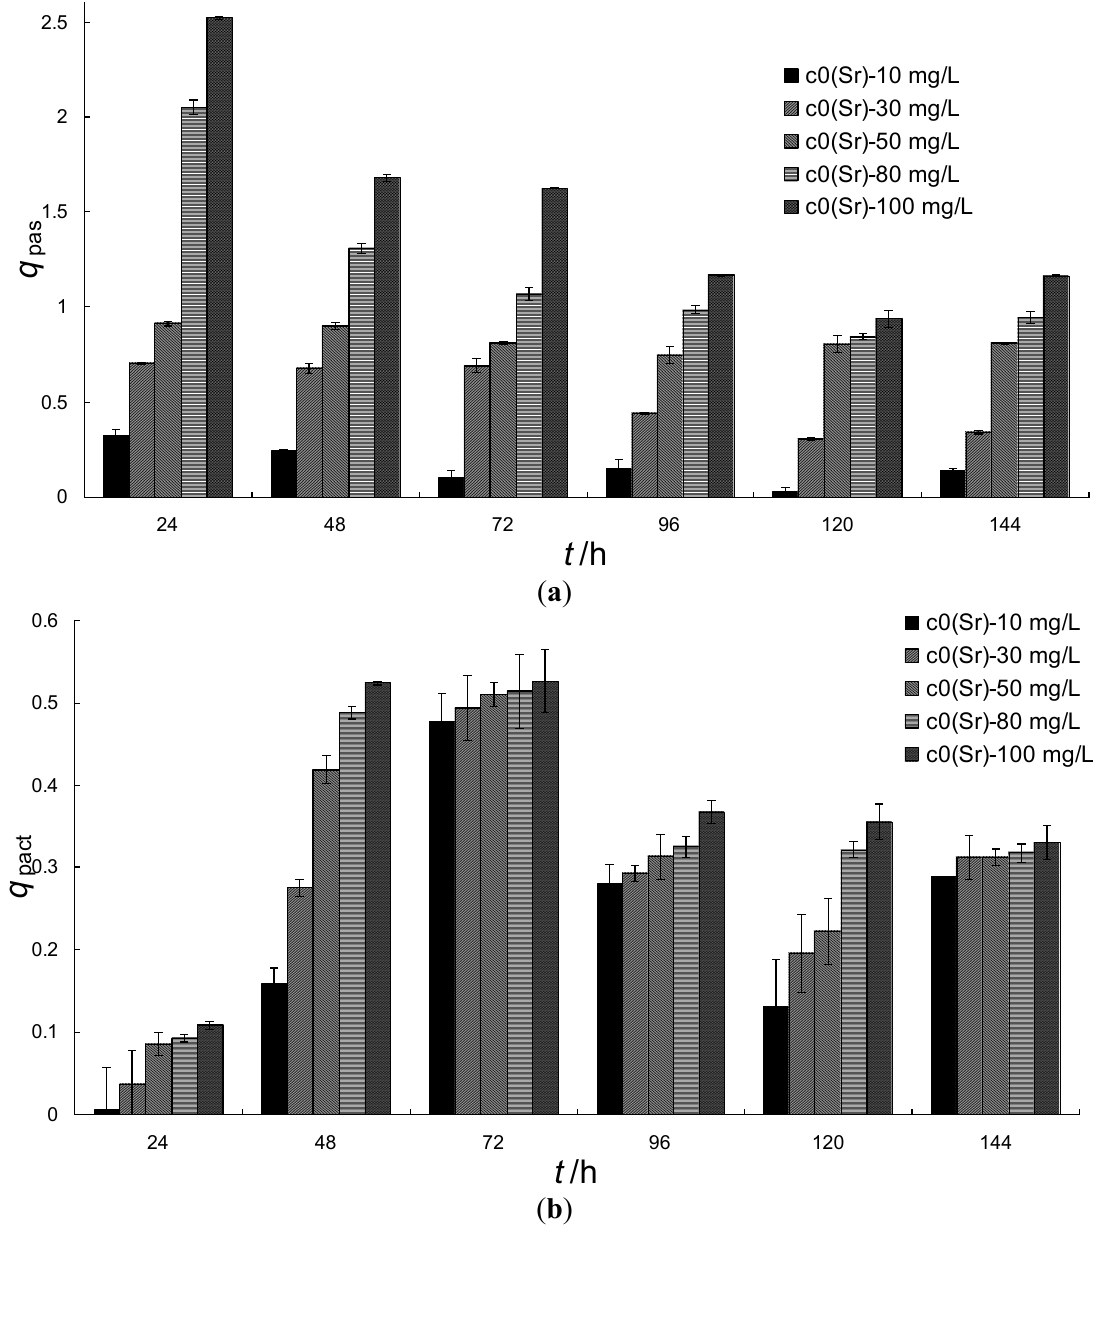
Figure 4. ( a ) The adsorption of strontium ions by S. spinosus cells from simulated wastewater ( q - t ); ( b ) The bioaccumulation of strontium ions by S. spinosus cells from pas simulated wastewater ( q - t act